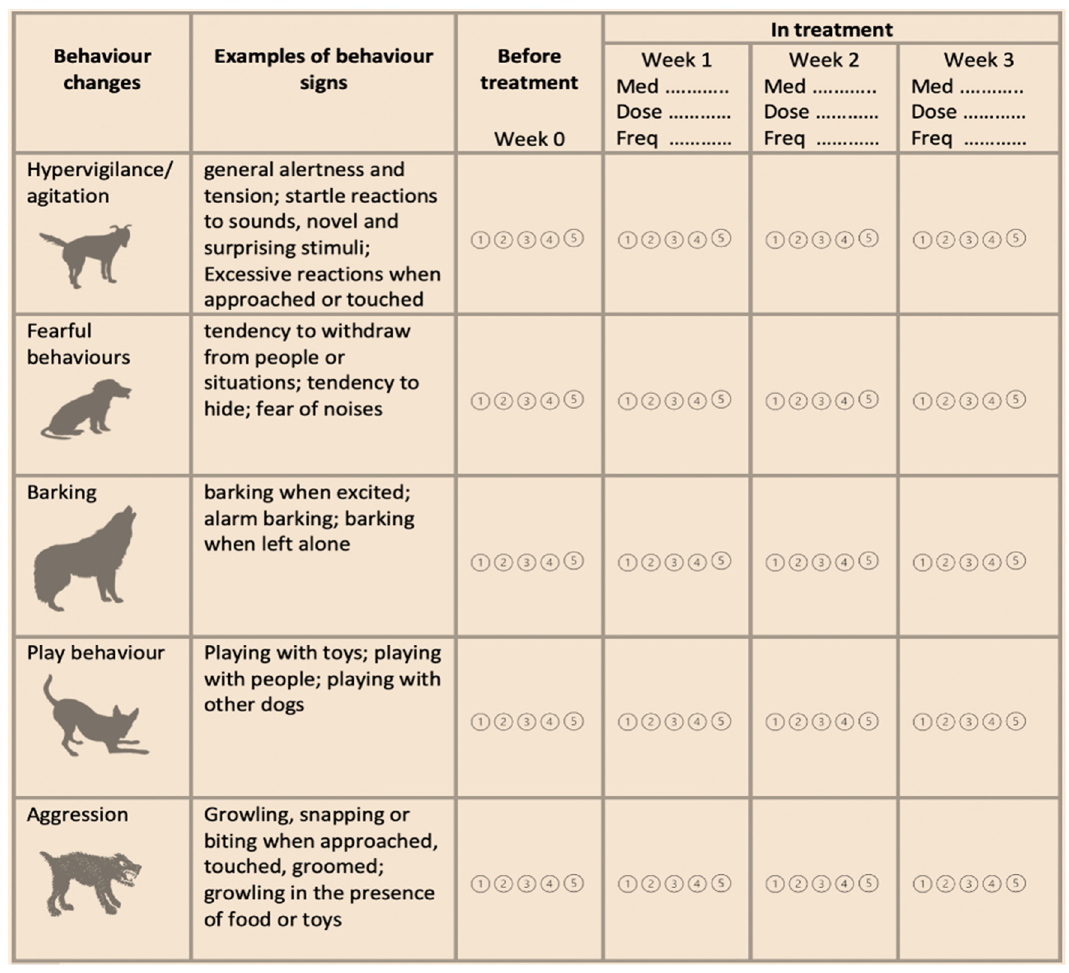
Figure 2. Example of weekly monitoring of dog behaviour when in treatment with exogenous corticosteroids. Owner should be asked to rate the presence of behavioural signs from one to five. = Never; = Rarely; = Sometimes; = Often; = Very often; Med. = name of the medication; Dose = dose of the medication; Freq = frequency of administration.